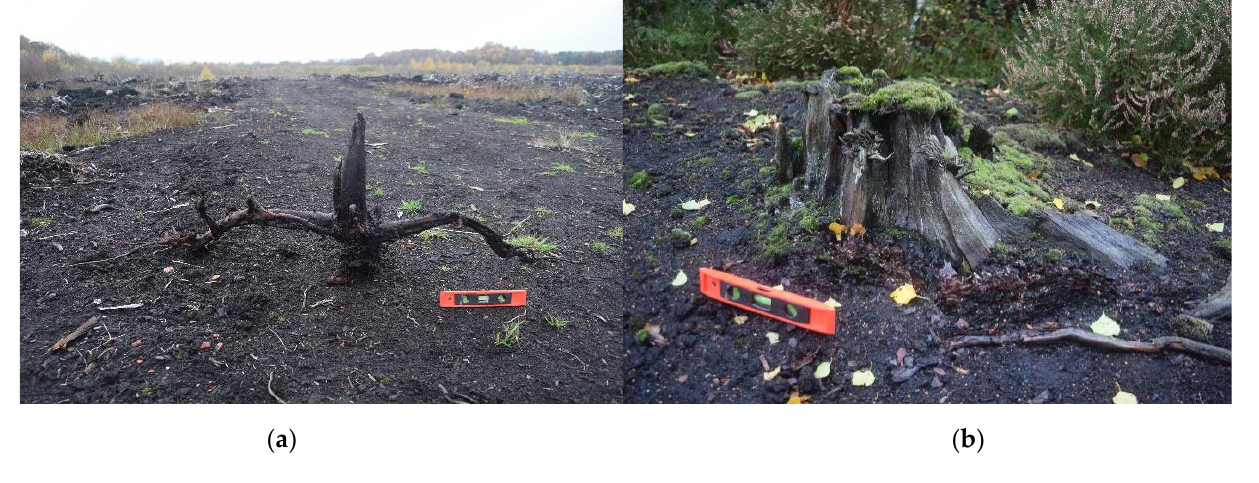
Figure 1. Subfossil bog pine ( P. sylvestris ) at Lindow Moss, Cheshire, UK. ( a ) Ex situ small diameter tree removed from an upper ‘regeneration layer’ in ombrotrophic peat– note c 20 cm of vertical trunk component facilitating sampling for dendrochronology. ( b ) In situ stump demonstrating some damage caused during mechanised peat extraction, but also limited surviving trunk component. Scale length 23 cm.